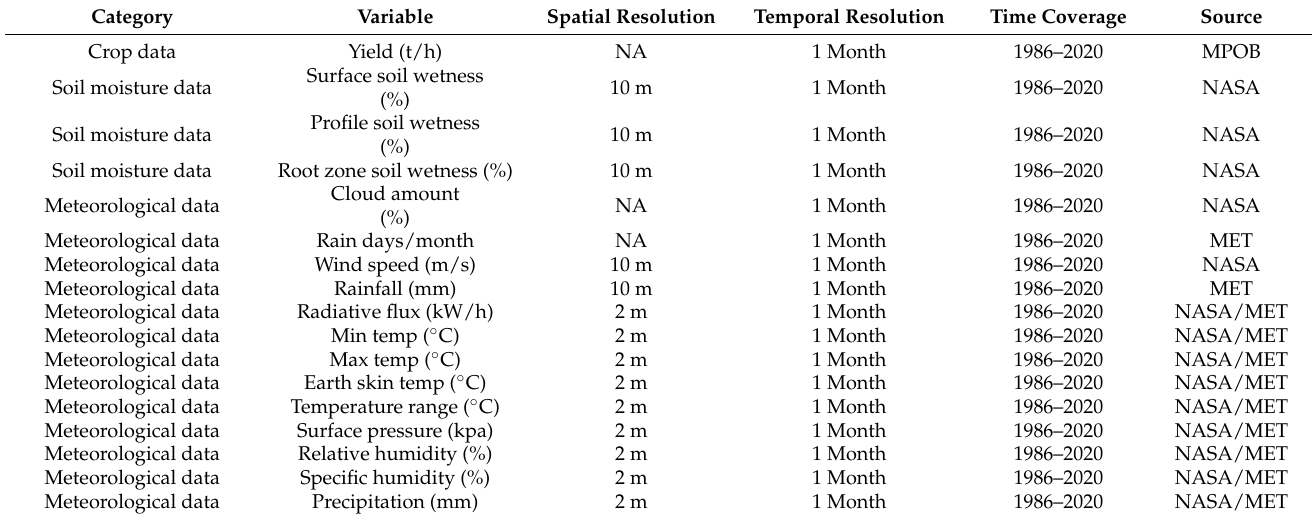
Table 1. A detailed summary of input data for yield modeling.